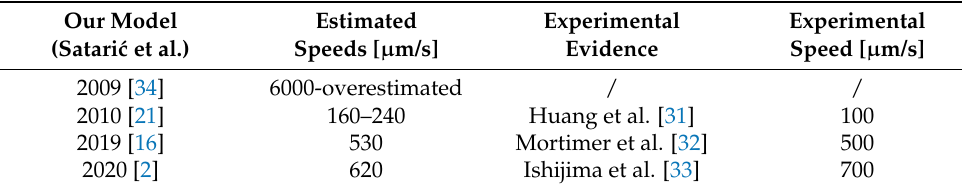
Table 1. A comparison between our estimated speeds and experimental values measured by different